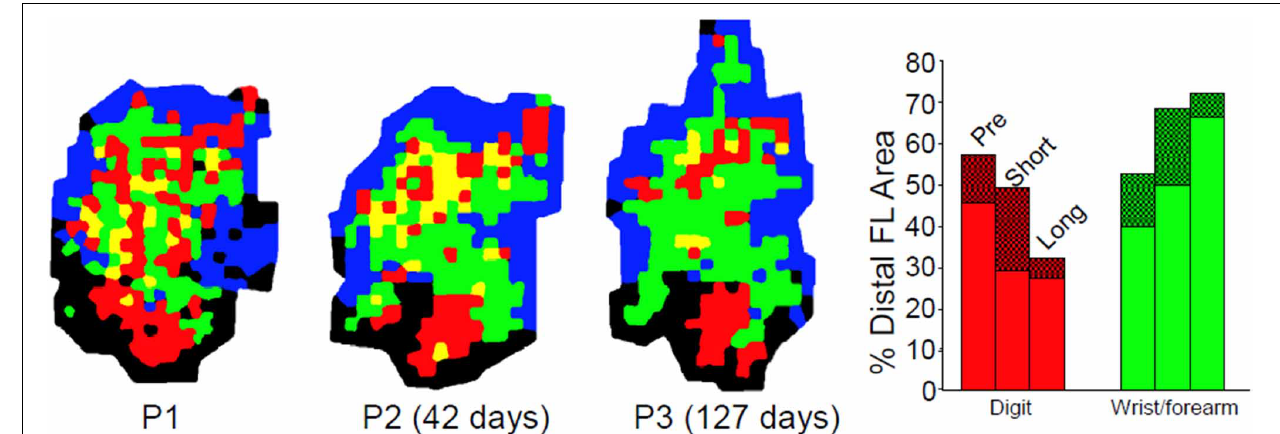
FIGURE 7 | Effects of disuse on motor maps in the absence of injury. The preferred forelimbs of normal, healthy adult squirrel monkeys were placed in soft, restrictive casts for periods up to 5 months. ICMS mapping studies showed a progressive decrease in digit representation and a progressive increase in wrist/forearm